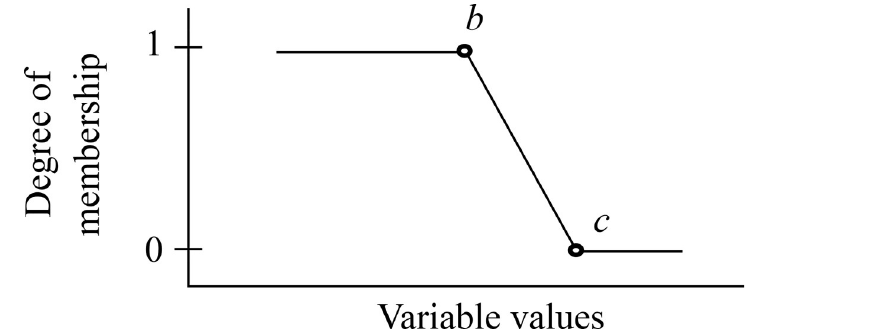
Fig 6. The half triangular membership function (Right-hand side).